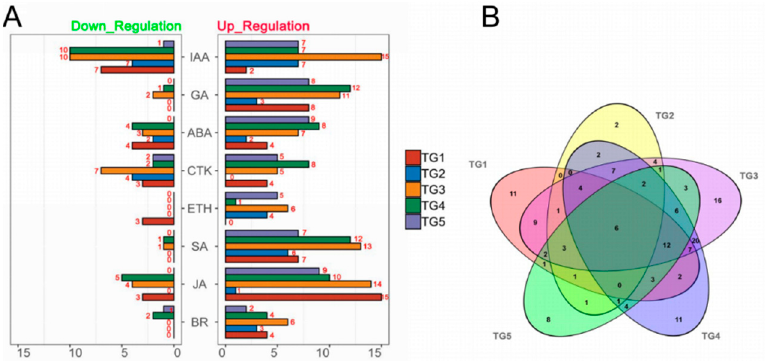
Figure 3. Enriched Kyoto Encyclopedia of Genes and Genomes (KEGG) pathways of the differentially expressed genes (DEGs). KEGG pathways with corrected p -value <0.05 were considered significantly enriched.